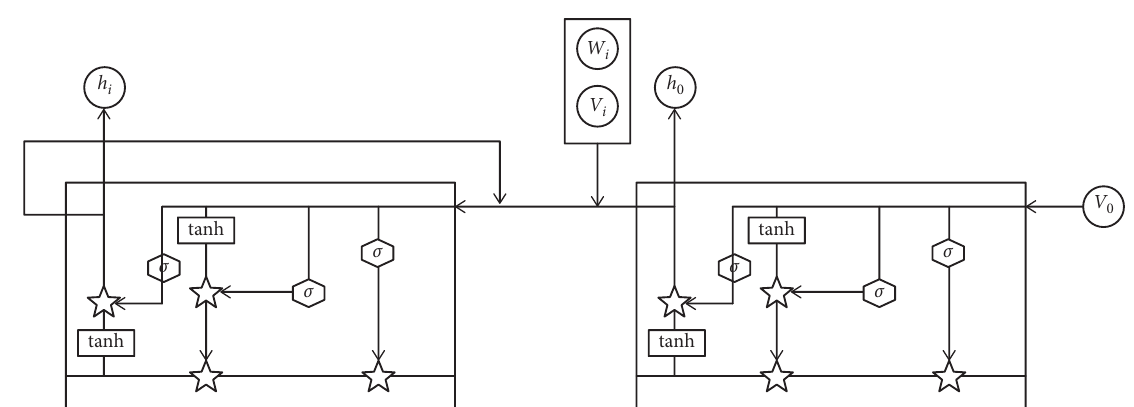
Figure 3: Structure of the language model.